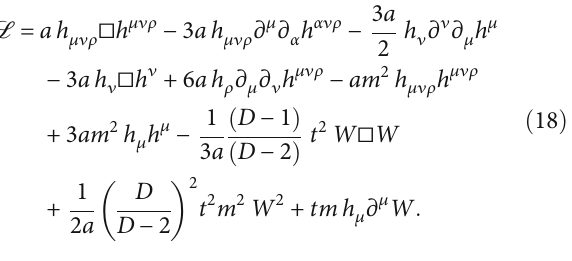
ffiffiffiffiffiffiffiffiffiffiffi